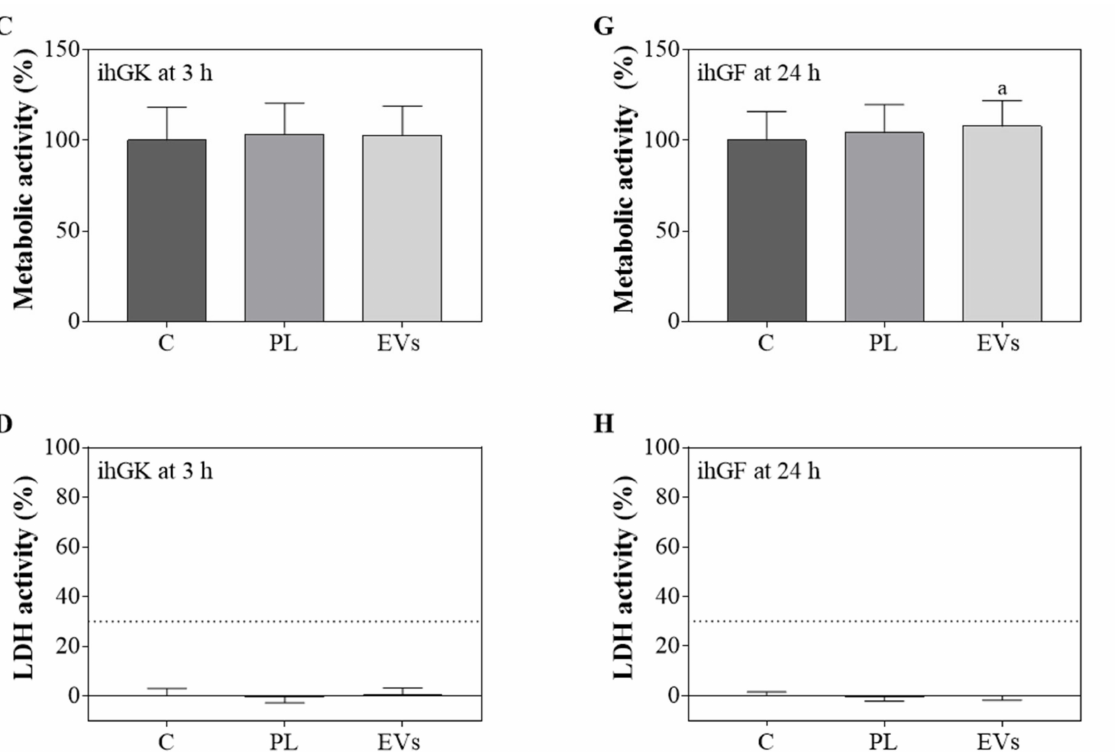
Figure 2. Effects of PL and EV treatments after the wound healing assay. ( A ) Images of ihGK cell morphology at t = 0 h and t = 3 h of treatment; images were taken at × 100 augments. ( B ) Wound closure area after 3h of treatment of ihGK. ( C ) Metabolic activity of ihGK after 3 h of treatment; data of the control group was set as 100%. ( D ) LDH activity measured in ihGK culture media after 3 h of treatment; control group was set as 0% of toxicity and culture media from cells treated with 1% Triton X-100 was set at 100%. A dashed line is shown at 30%, which is the maximum value accepted for cytotoxicity of medical devices according to ISO-10993:5. ( E ) Images of ihGF cell morphology at t = 0 h and t = 24 h of treatment; images were taken at a × 100 augments. ( F ) Wound closure area after 24 h of treatment of ihGF. ( G ) Metabolic activity of ihGF after 24 h of treatment; data of the control group was set as 100%. ( H ) LDH activity measured in ihGF culture media after 24 h of treatment; control group was set as 0% of toxicity, and culture media from cells treated with 1% Triton X-100 was set at 100%. A dashed line is shown at 30%, which is the maximum value accepted for cytotoxicity of medical devices according to ISO-10993:5. Values represent the mean ± SEM. For ihGK, 9 independent experiments, with at least duplicate wells per group ( n = 9), were performed, while for ihGF, 10 independent experiments, with at least duplicate wells per group ( n = 10), were performed. Results were statistically compared by paired t -test. Statistically significant differences were considered for p < 0.05 and represented with “a” compared to control or “b” compared to PL. Additionally, mRNA expression levels for different marker genes were evaluated for both cell lines (Figure 3). PL- and EV-treated ihGK for 3 h showed a significant increase in FN1 mRNA expression, but no differences were observed for VIM mRNA levels (Figure